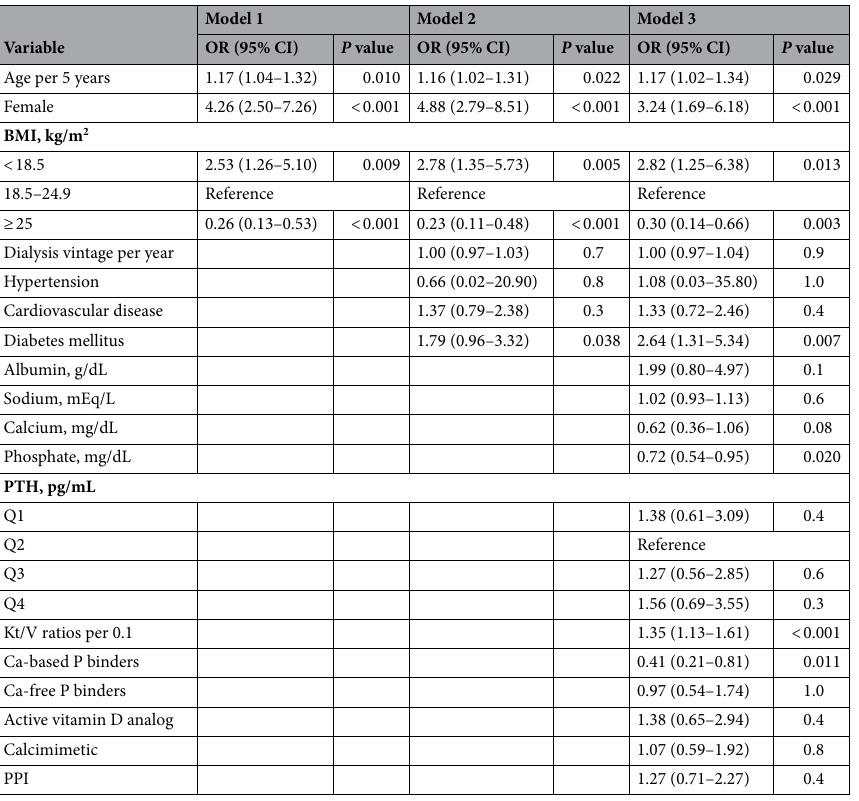
Table 2. Factors associated with a risk of osteoporosis in maintenance hemodialysis patients. Multivariate logistic regression analysis for assessment of osteoporosis risk factors. Model 1, adjusted for age, sex, BMI. Model 2, age, sex, BMI, dialysis vintage year, hypertension, CVD, diabetes mellitus. Model 3, age, sex, BMI, dialysis vintage year, hypertension, CVD, diabetes mellitus, albumin, sodium, calcium, phosphate, iPTH, Kt/V ratios, CBPBs use, CBPB use, active vitamin D analogs use, calcimimetics use, and PPI use. Odds ratios (ORs) with the corresponding 95% confidence intervals (95% CIs). P < 0.05 was considered significant. BMI, body mass index; Ca, calcium; P, phosphate; PPI, proton pump inhibitor; PTH, parathyroid